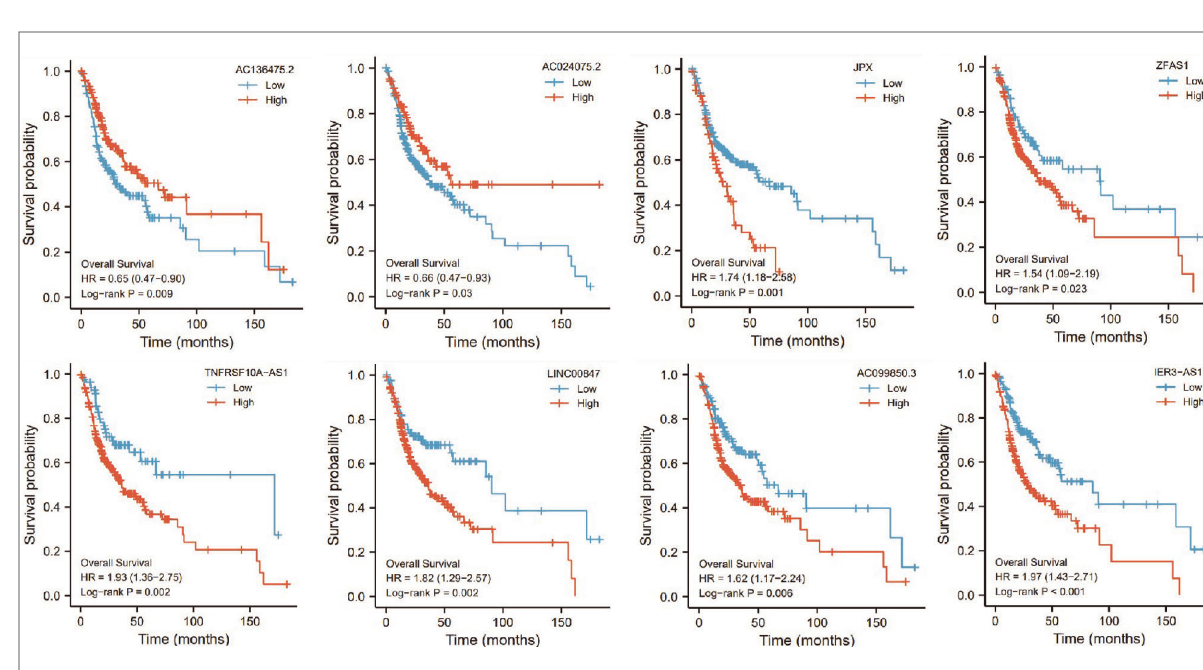
FIGURE 7 The in fl uence of eight genes (AC136475.2, AC024075.2, JPX, ZFAS1, TNFRSF10A-AS1, LINC00847, AC099850.3, IER3-AS1) on survival